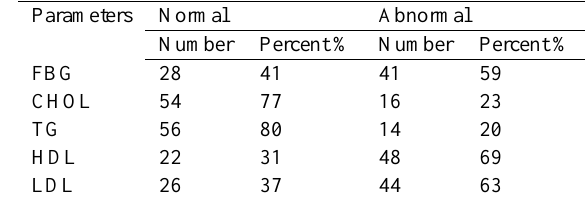
Table 3: Comparison of FBG and Lipid profile in cases according to normal rang.